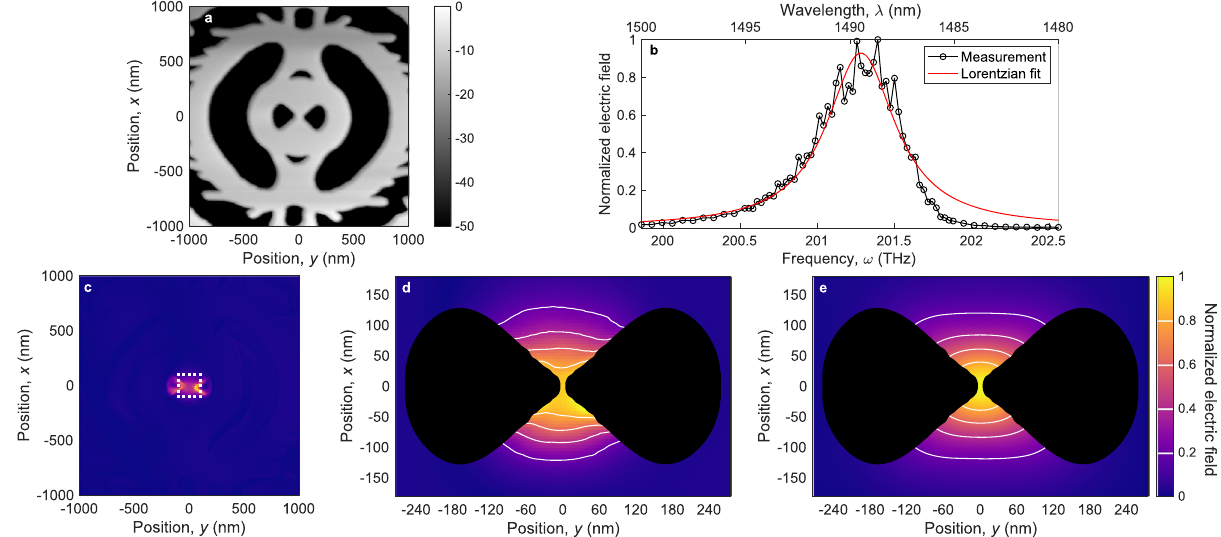
Fig. 3 | Scattering-type scanning near- fi eld optical microscopy (s-SNOM) of tocomplexinteractionsbetweentheAFMprobeandthecavitymode. d Normalized cavity mode. a Topography measured by atomic force microscopy (AFM). measured amplitude of the light scattered from the cavity surface with the voids b Spectrum measured of amplitude of scattered fi eld with Lorentzian fi t, blacked out. e Numerical simulation of experiment, f ( σ =37nm) ∗∣ E c ∣ 2 , con fi rming Q =370±40. c s-SNOM signal on resonance demon- λ photon localization below the instrument response function as explained in the 0 =(1489.4±0.1)nm and strating strong fi eld localization with excellent suppression of background noise. main text. The s-SNOM measurements presented here were performed on cavity The white dotted box highlights a square domain with its side length given by the copy 3 ( δ = − 4nm), which has a mean bowtie width of diffraction limit, λ 0 /(2 n Si )~200nm. The strong signal in the cavity voids arises due